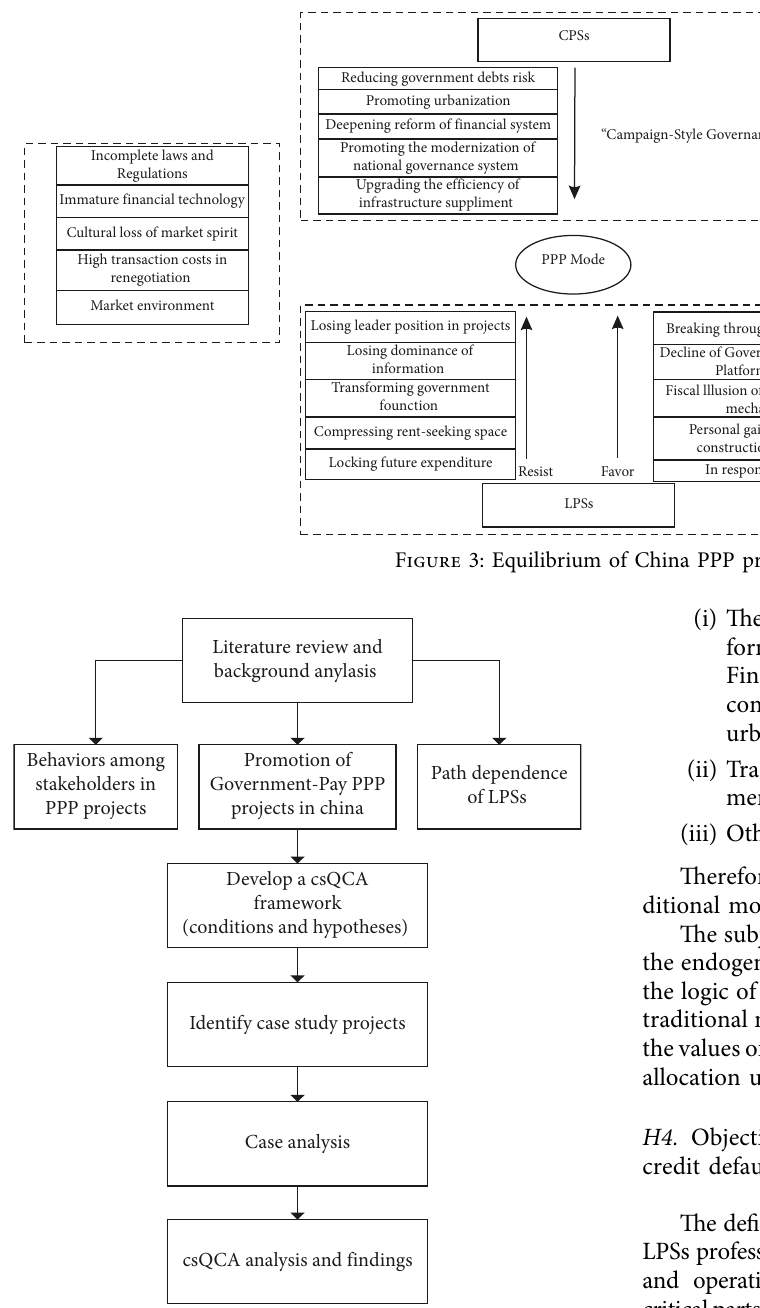
Figure 4: Diagram of the research